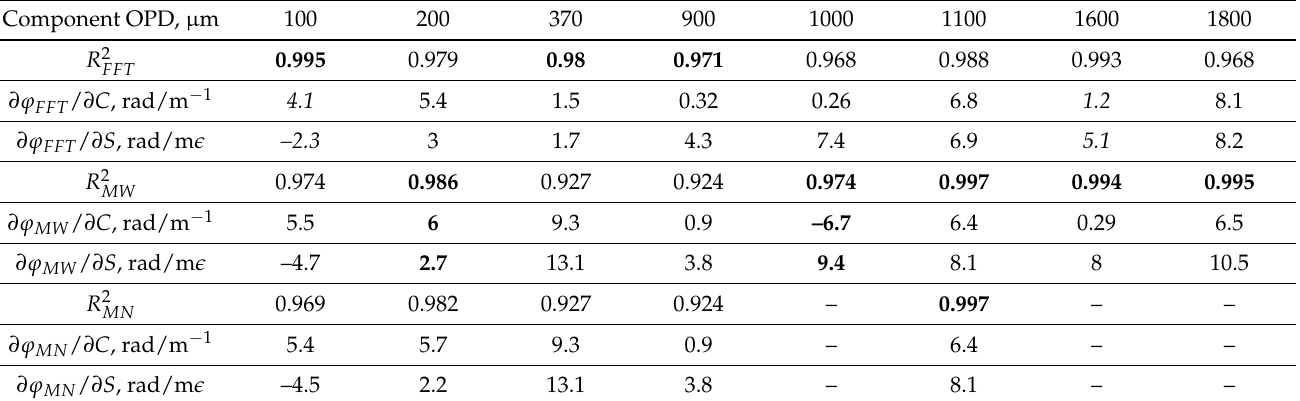
Table 3. Linearity of demodulated parameters of different interference components with respect to strain and bending of SMS